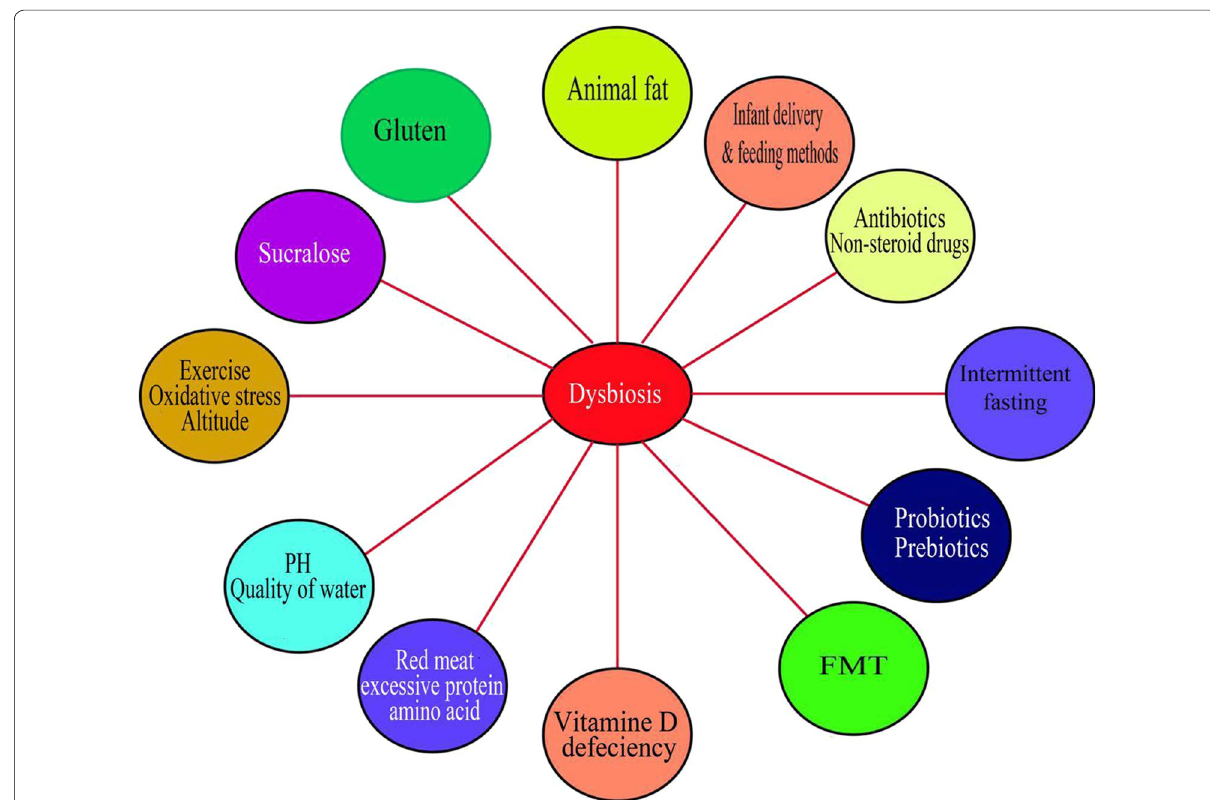
Fig. 1 Factors causing alteration to gut microbiota. Diet rich in protein, animal fats and high carbohydrate, sucralose and diet containing gluten all contributed to dysbiosis. Exercise and intermittent fasting are studied to both starve the bad microbes and clean the gut. Method of delivery for the newborn baby and the feeding methods determine the childhood immunity and this period is crucial for the development of human life. The pH level or water quality are as well among the factors associated with dysbiosis. In addition, drugs including antibiotics, non-steroids anti-inflammatory drugs, Prebiotics and Probiotics adversely affected the gut microbiota composition. Other factors are vitamin D deficiency, oxidative stress, temperature and fecal microbial